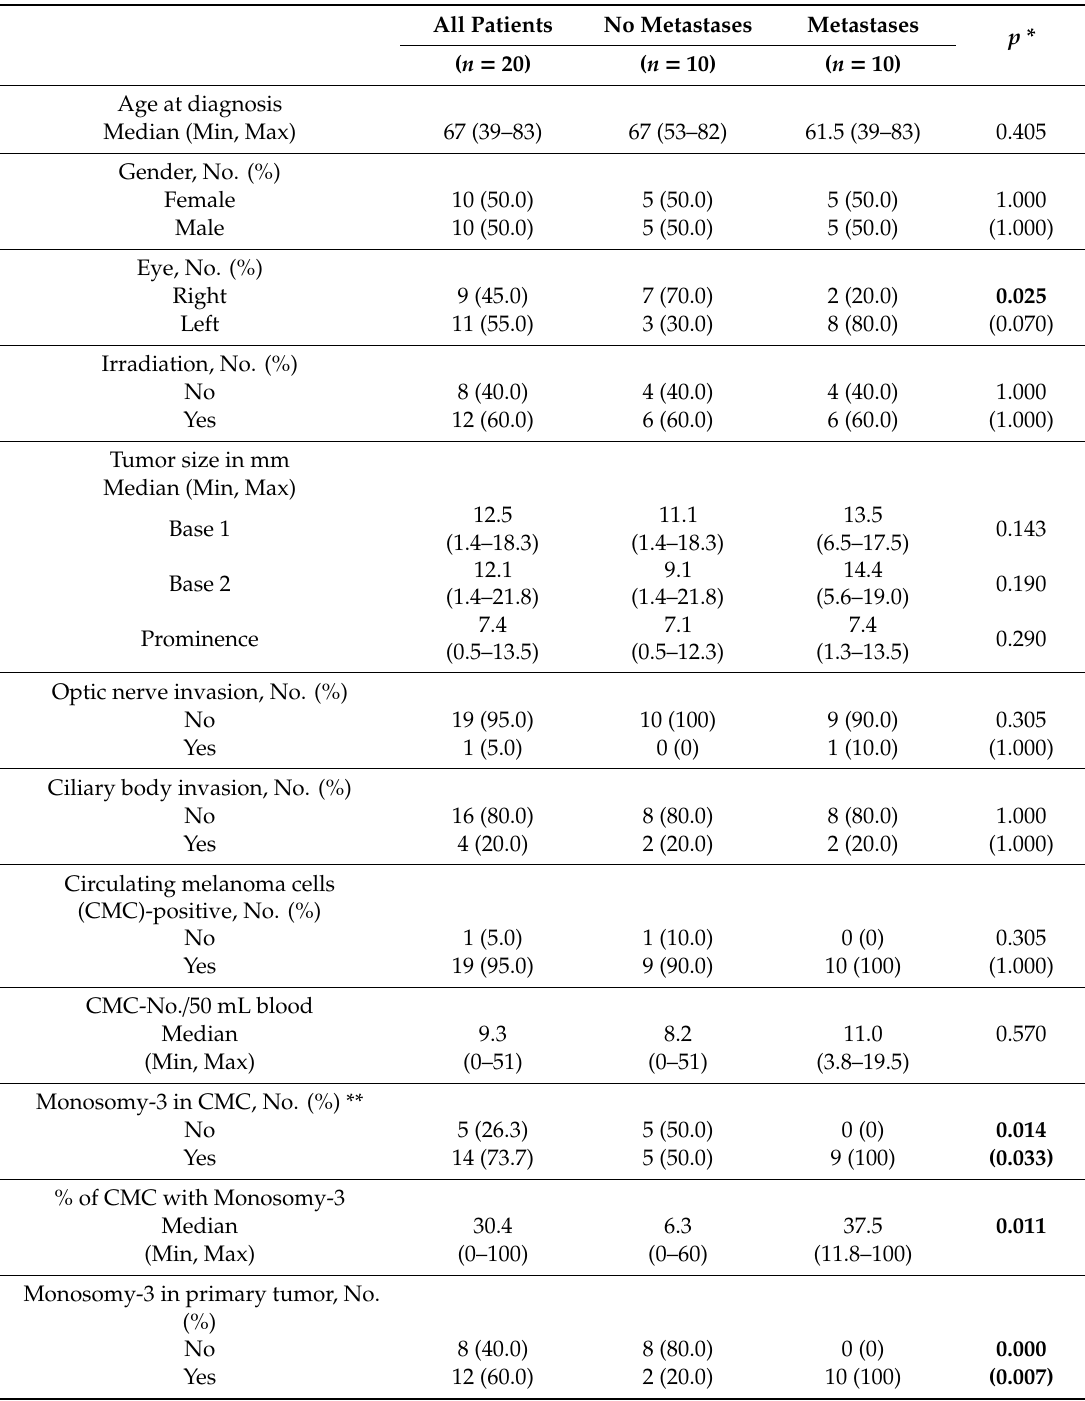
Table 2. Association of systemic uveal melanoma (UM) metastases with clinical parameters and the levels of the glucose transporters GLUT1-3 (Follow-up time: 2–9